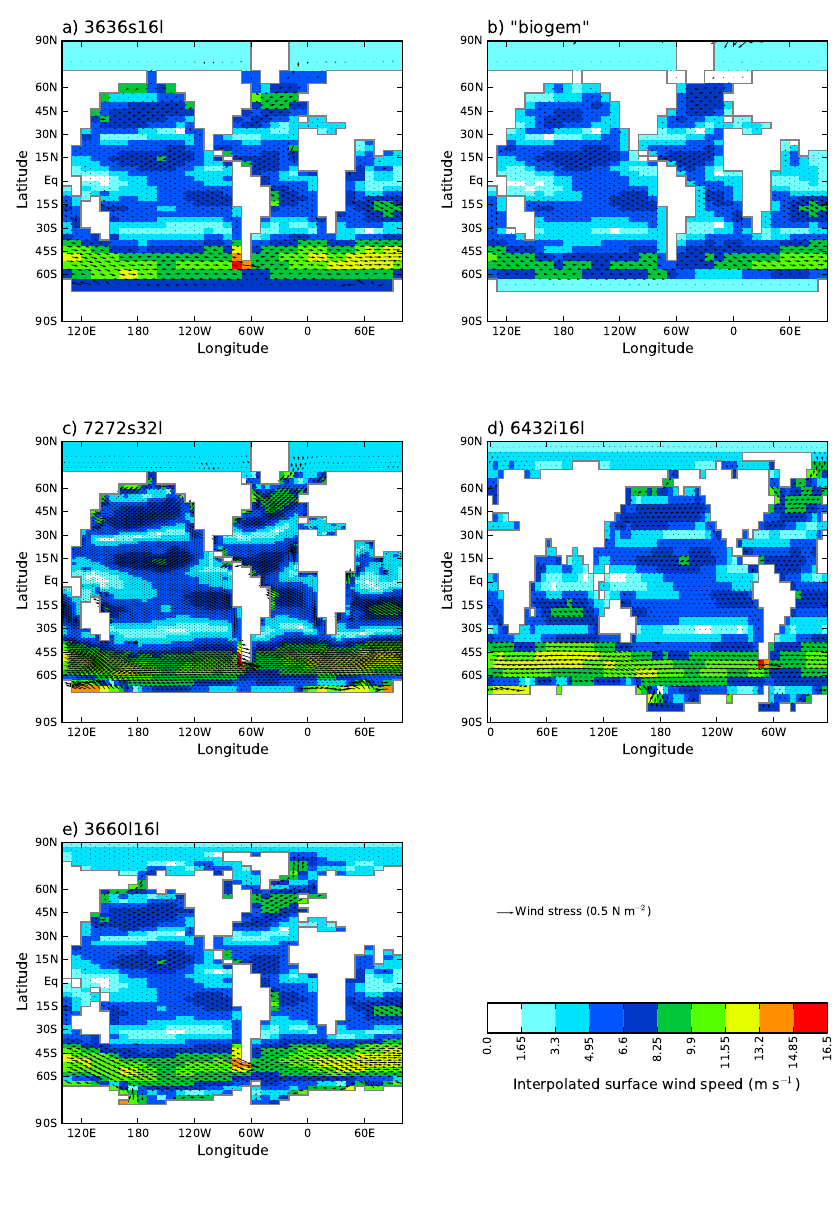
Fig. 2. Annual-mean wind stress (arrows) and derived surface wind speed (colours) for each configuration.